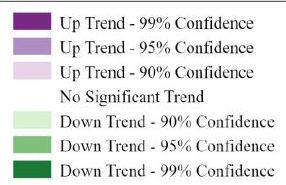
Figure 3 Legend of the trend analysis maps.